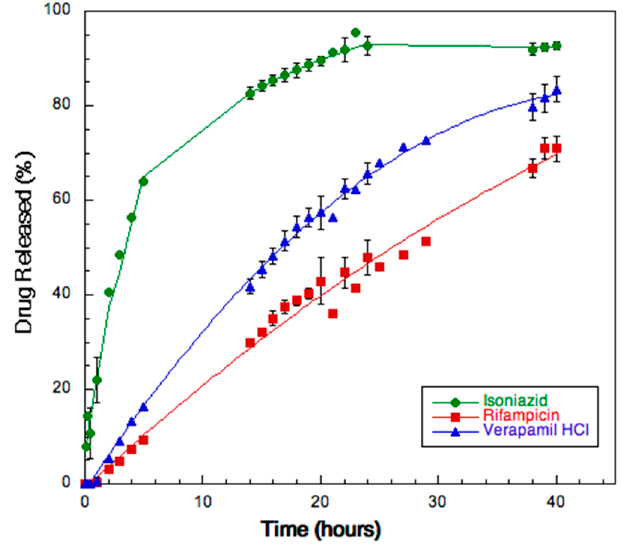
Figure 7. Release profiles of the three drugs from SD powder A.